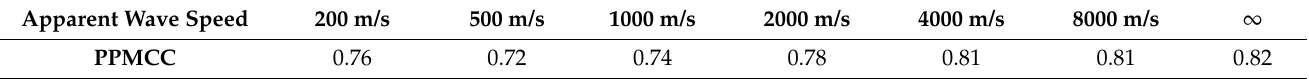
Table 9. Numerical value of PPMCC of displacement and stress at point A.